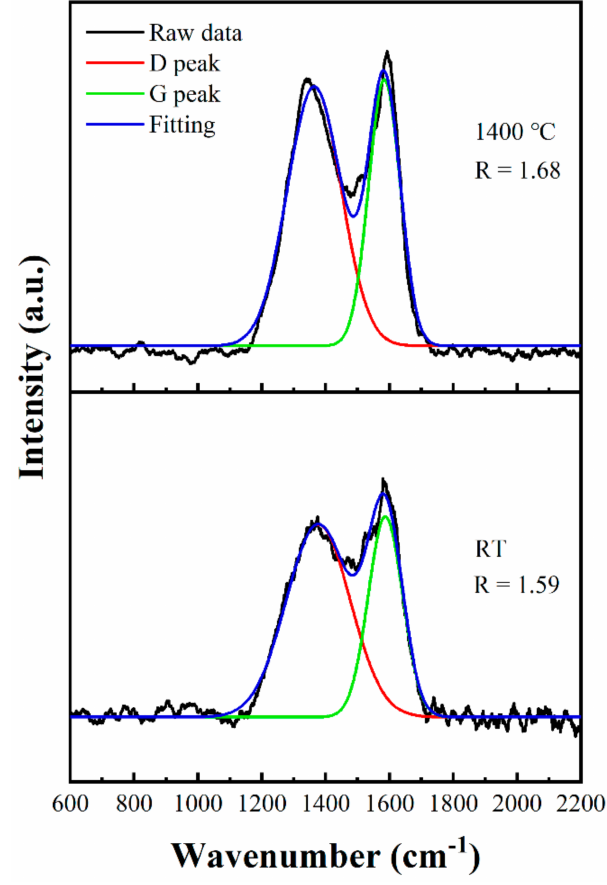
Figure 9. Raman spectra of carbon